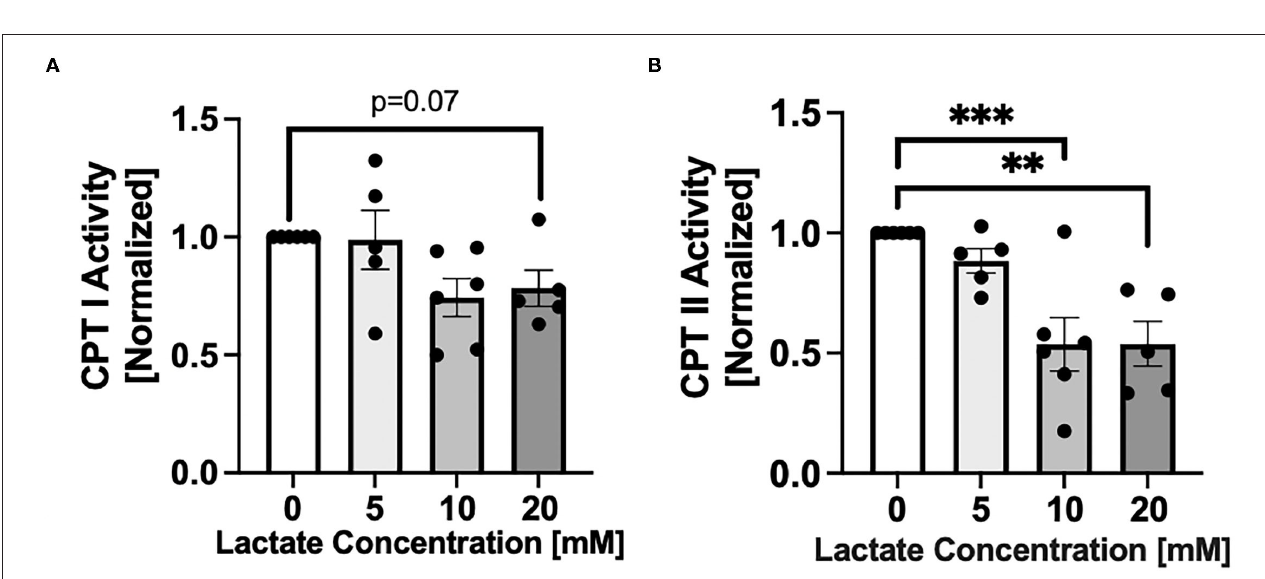
FIGURE 1 | Uptake of Lactate into NRVMs (A) Extracellular media concentrations of lactate before (white bars) and after (gray bars) 48h of lactate treatment. Numbers above bars indicate average of each measurement. (B) Intracellular lactate concentrations in NRVMs treated for 48h with various concentrations of lactate. N = 3 plates, n = 1 solution ( A white bars); error bars show standard error of the mean. *Intracellular lactate concentration is measured by mM of lactate per mg/ml of protein [mM/mg/ml protein).